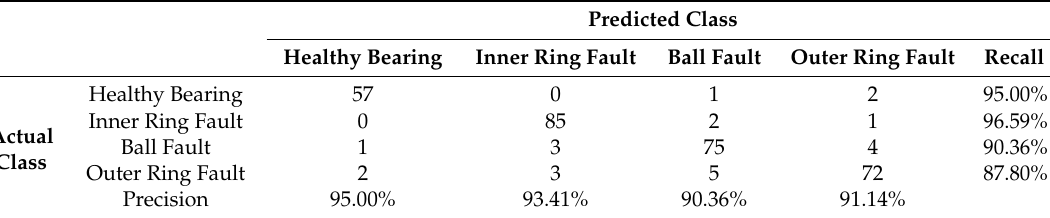
Table 2. Classification rate of LDA model (Test